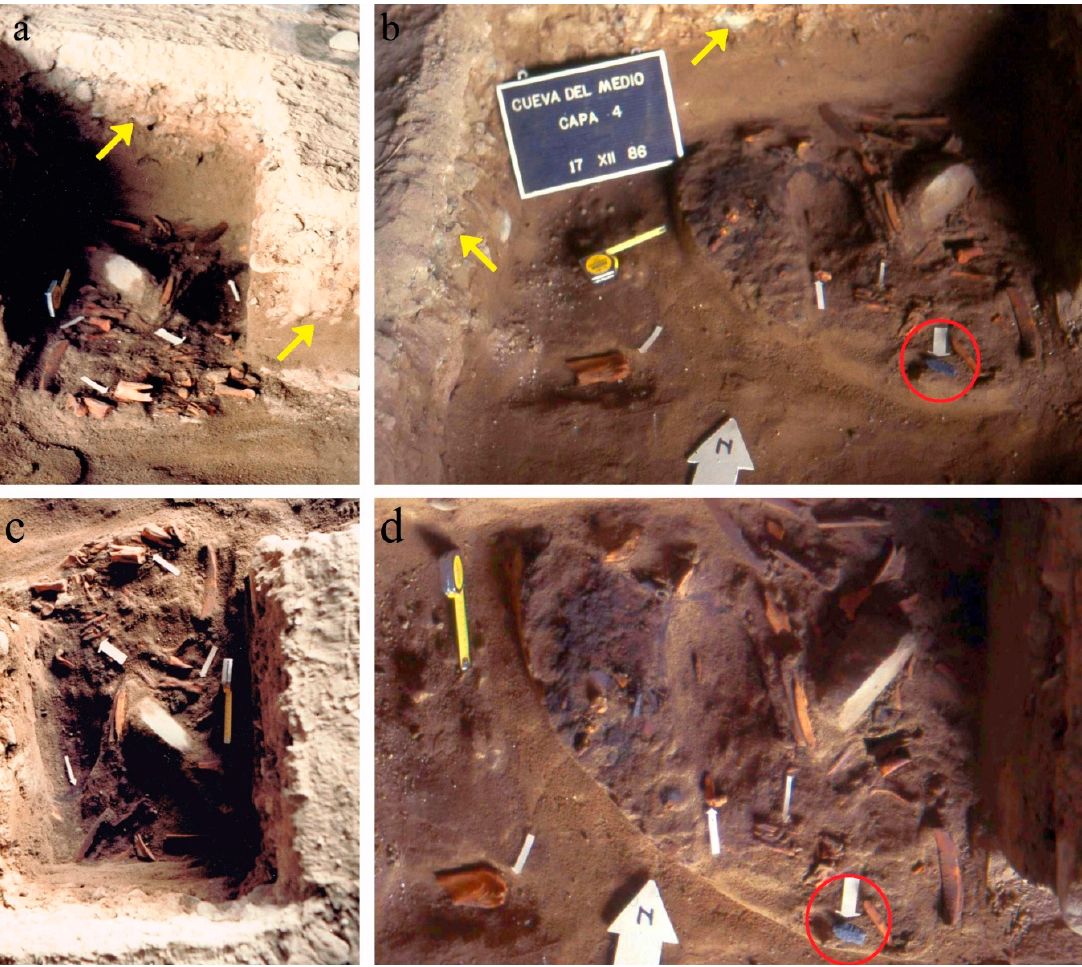
Figure 8. Frontal ( a , b ) and upper ( c , d ) views of one of the hearths found at CM, Hippidion saldiasi bones and a Fell point indicated by the arrow and red circles in ( b , d ). Note the pebble layer sealing the archaeological remains pointed with yellow arrows.